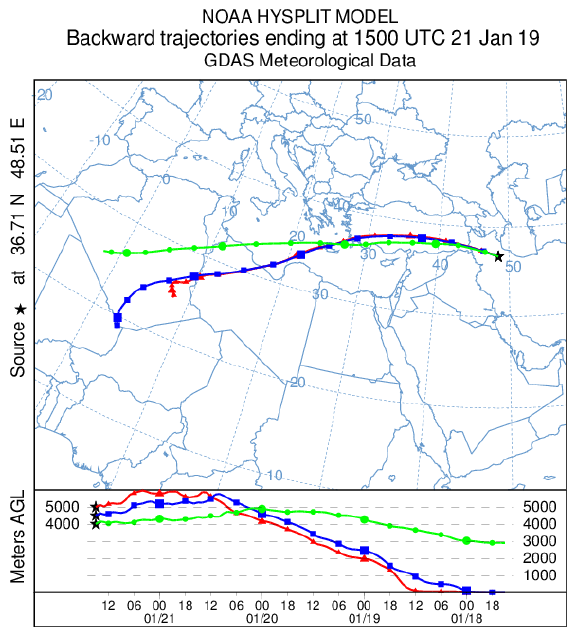
Figure 3 96 h HYSPLIT backward trajectories arriving to Zanjan on 15:00 UTC, 21 January 2019 at 5, 4.5 and 4 km heights agl.